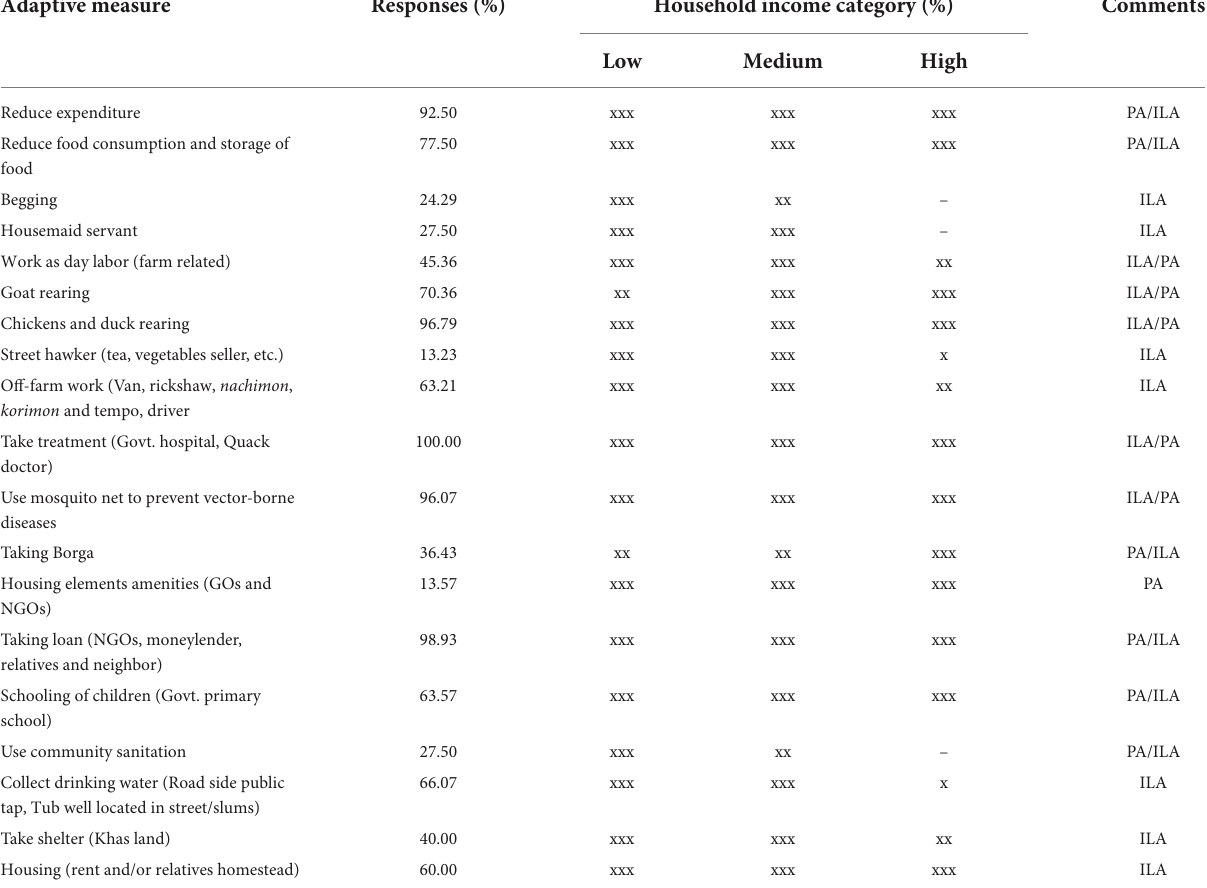
TABLE 5 Adaptation strategies of IDPs in the context of livelihood resilience.